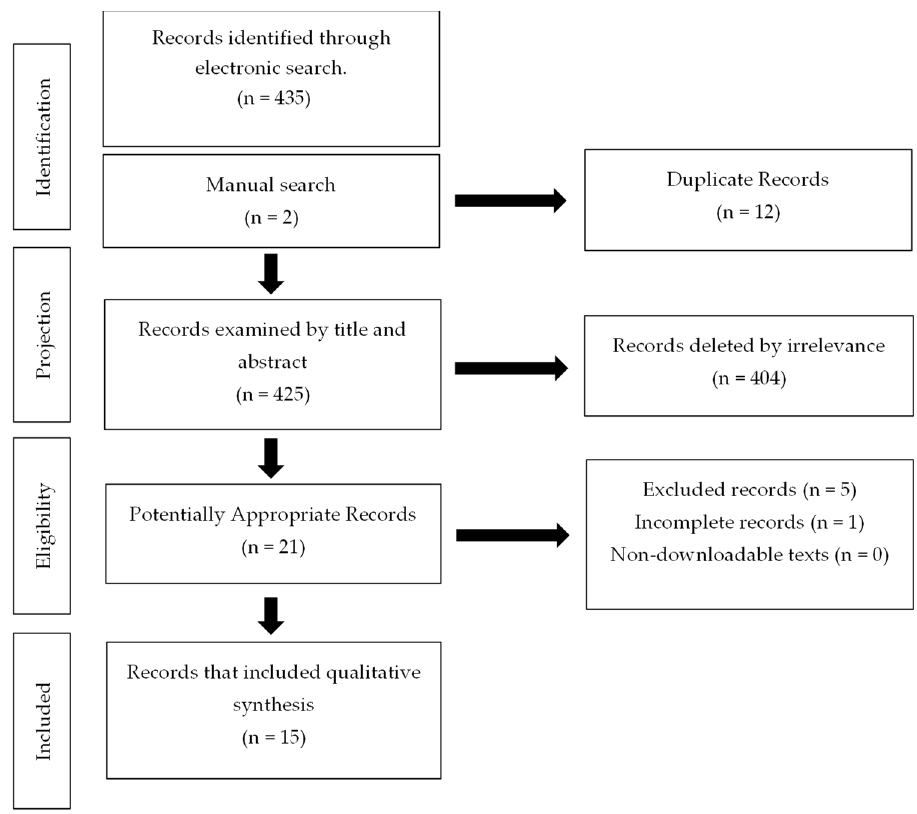
Figure 1. PRISMA flow diagram of record processing and elimination.